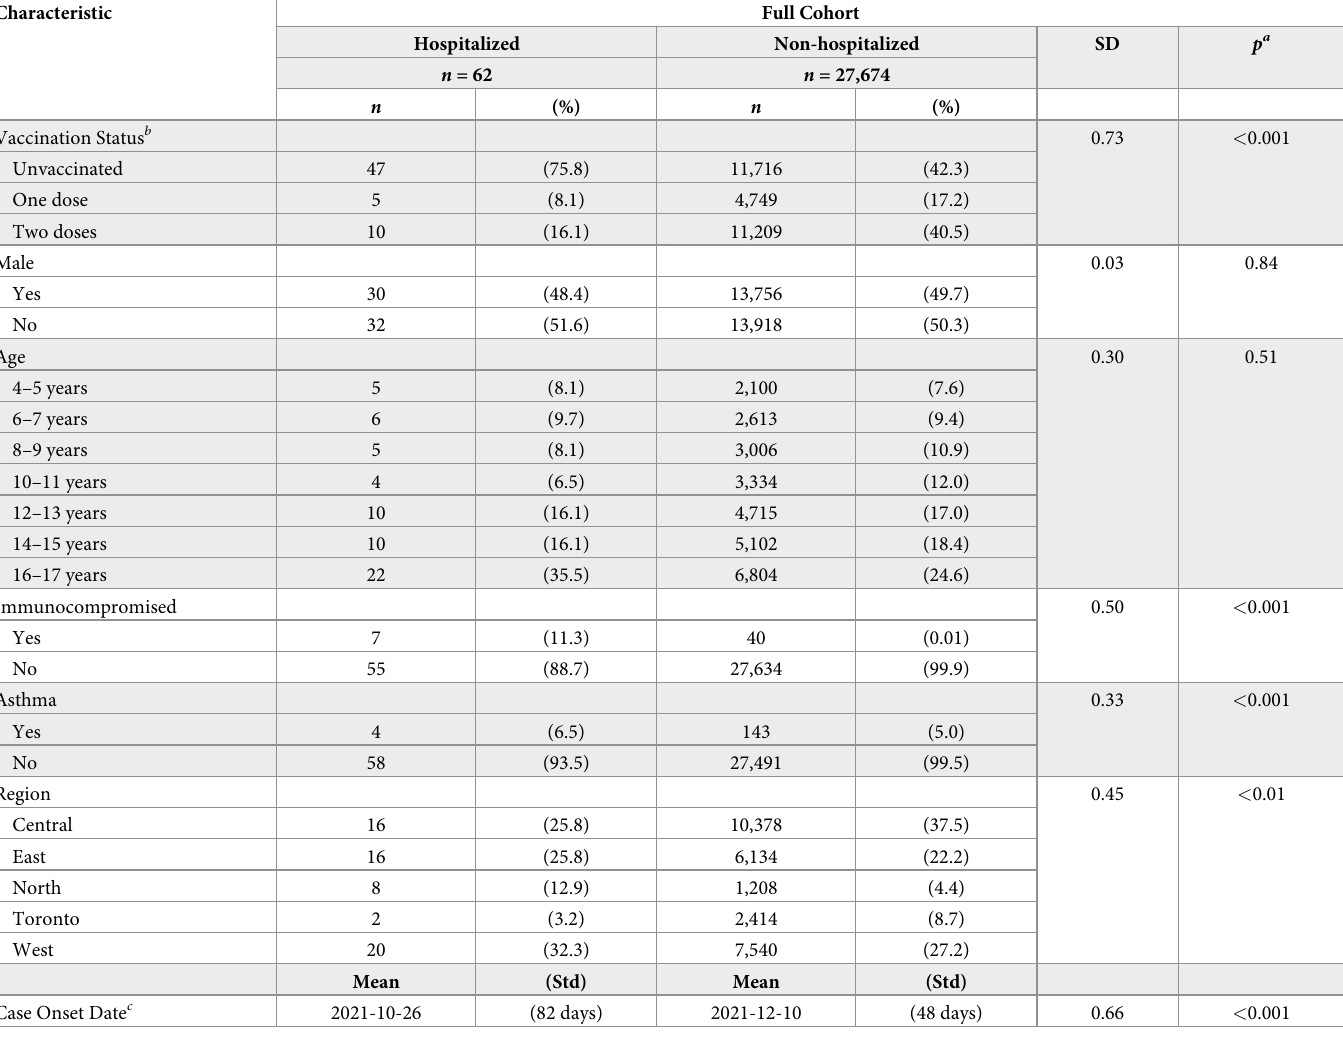
Table 1. Description of adolescent and pediatric SARS-CoV-2 cases by hospitalization status ( n = 27,736).